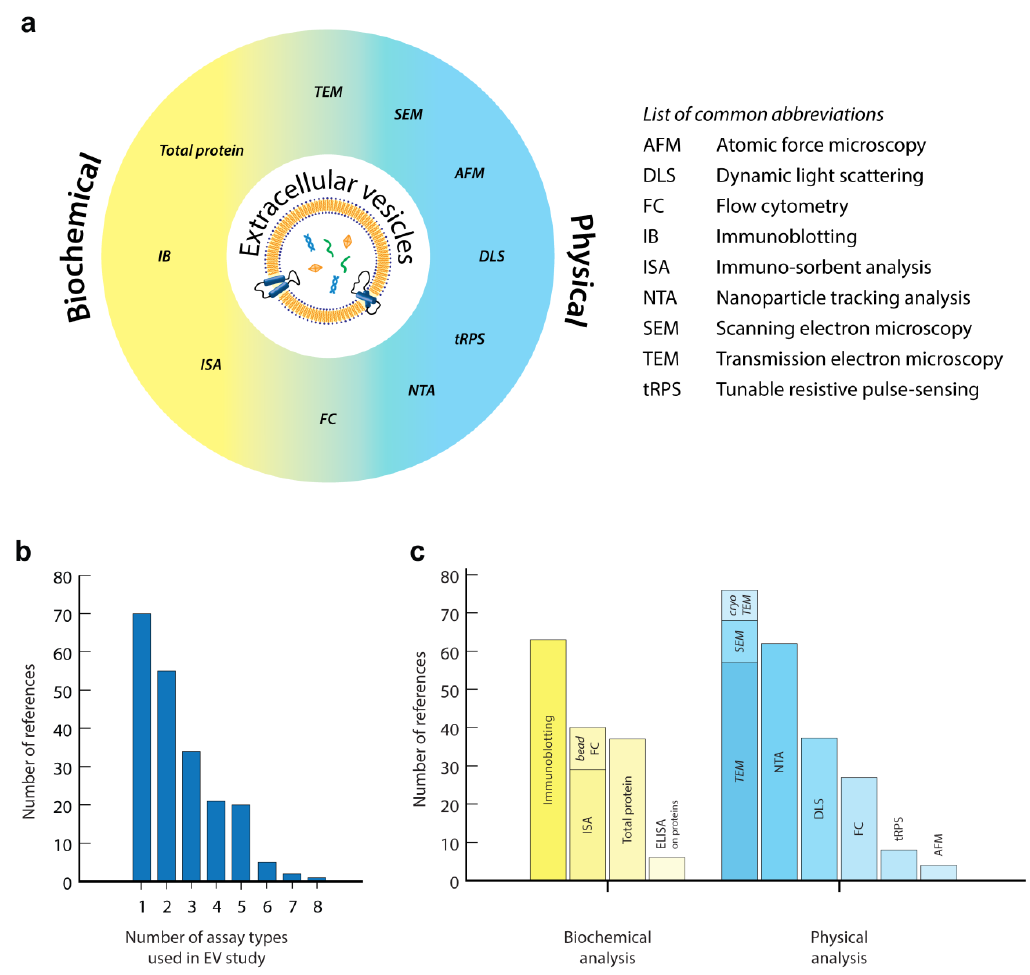
Figure 2. ( a ) Schematic classification of common technologies for EV analysis, as used in this review. ( b , c ) Analysis of the recent literature (5 years, 2013–2018) based on a PubMed search using the terms [extracellular vesicles] or [vesicles] or [exosomes] together with [quantification] in their title or